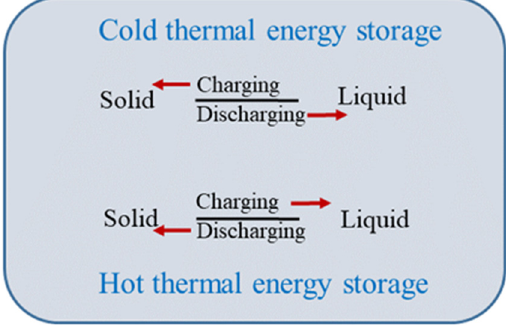
Figure 1. Mechanism of hot and cold thermal energy storage.